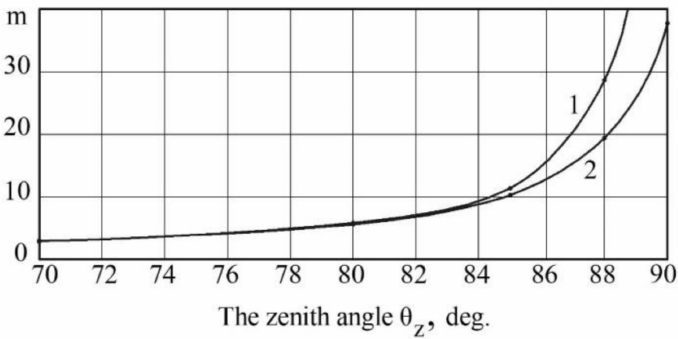
Figure 1. Optical air mass: 1—by the Equation (5), 2—by the Equation (7); (own